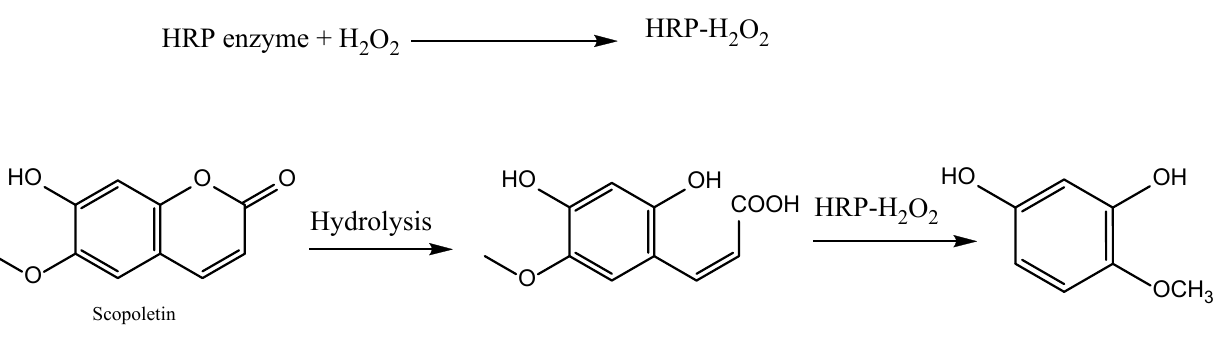
Figure 16. General mechanism of hydrogen peroxide scavenging [58].